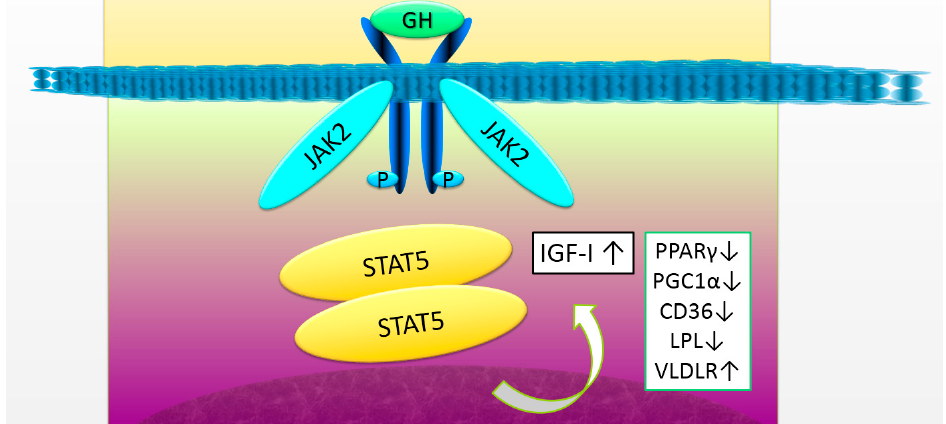
Figure 1. The growth hormone (GH) receptor signaling and target genes in the liver. GH binds to the GH receptor and activates the janus kinase 2 (JAK2)-signal transducer and activator of transcription 5 (STAT5) signaling pathway. Several target genes of STAT5, including insulin-like growth factor-I (IGF-I) and peroxisome proliferator-activated receptor γ (PPAR γ ), play an essential role in the liver. The decrease in GH receptor signaling induces a decrease in IGF-I expression, resulting in the progression of fibrosis. At the same time, an increase in the expression of PPAR γ , peroxisome proliferative activated receptor γ , coactivator-1 α (PGC1 α ), cluster of differentiation 36 (CD36), and lipoprotein lipase (LPL), and a decrease in the expression of very low density lipoprotein receptor (VLDLR), cause the impaired lipid metabolism, leading to steatosis. GH, growth hormone; IGF-I, insulin-like growth factor-I.